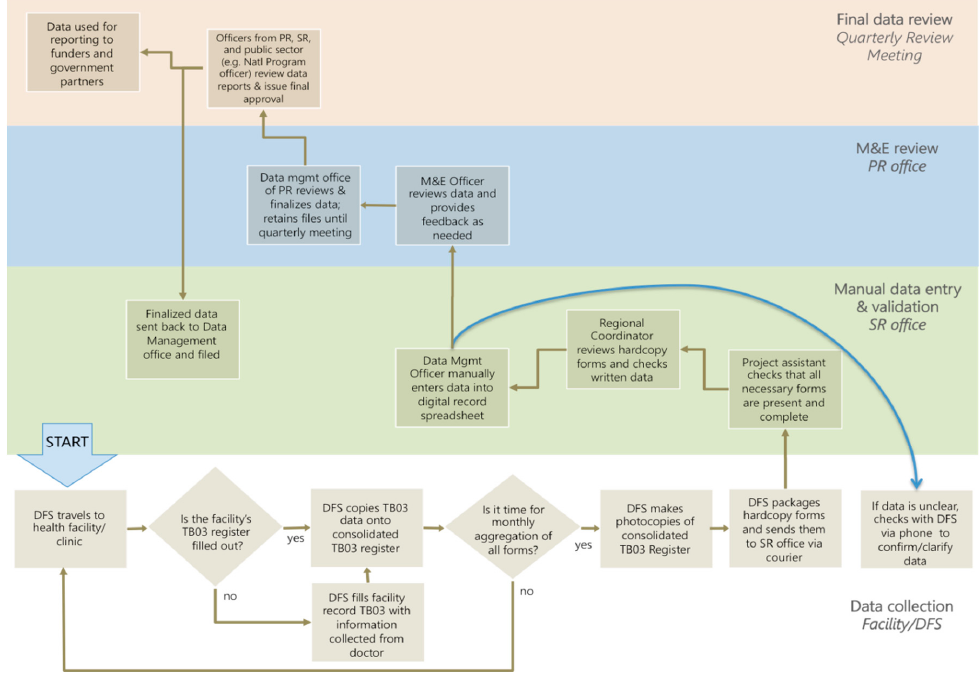
Figure 5. Routine data management process in the TB (Tuberculosis) control program of Pakistan.